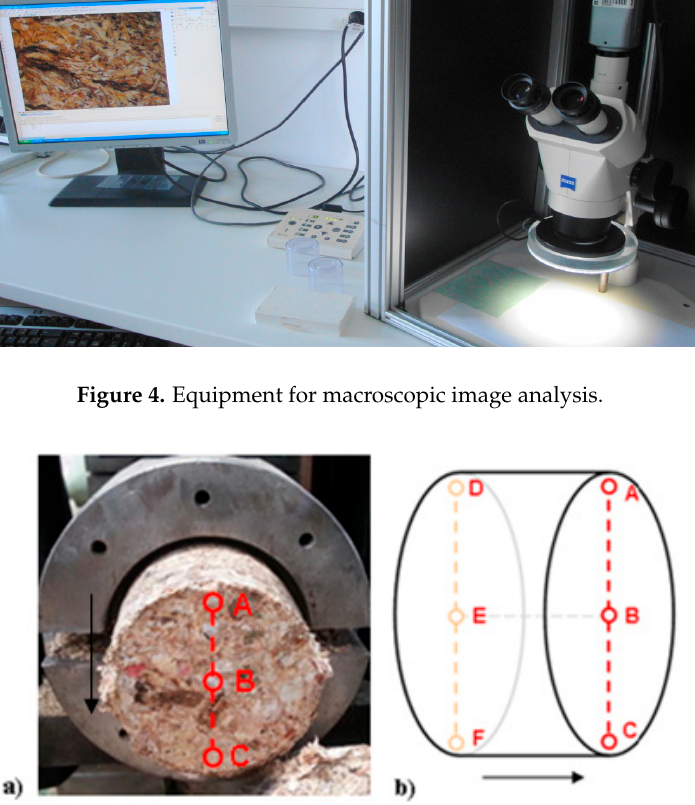
Figure 5. The scheme of analysed point, ( a ) position of briquette leaving from press die; ( b ) points A–C placed on the front side of the briquettes; D–F on the rear